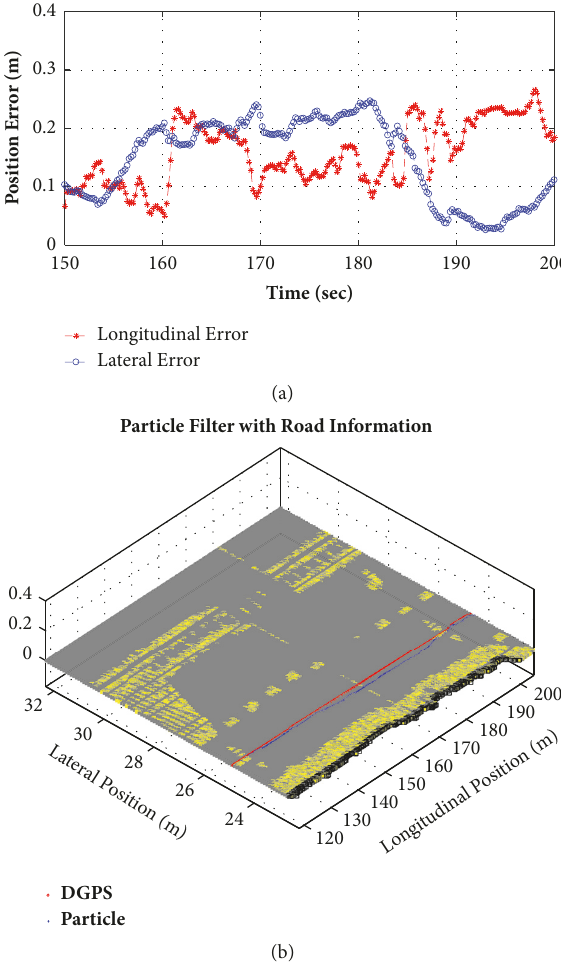
Figure 13: Particle filter localization at the third section (between 150 s and 200 s): (a) the position error and (b) the comparison of the trajectory obtained by the particle filter and the